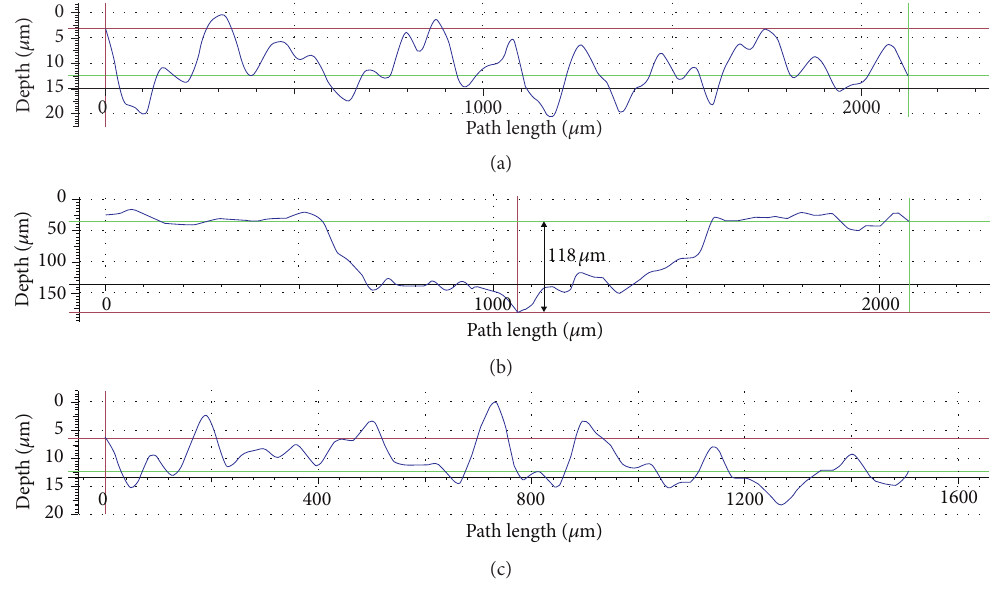
Figure 3: Surface profiles of three kinds of stainless steel after 7-day incubation: (a) 304 SS, (b) 410 SS, and (c) 2205